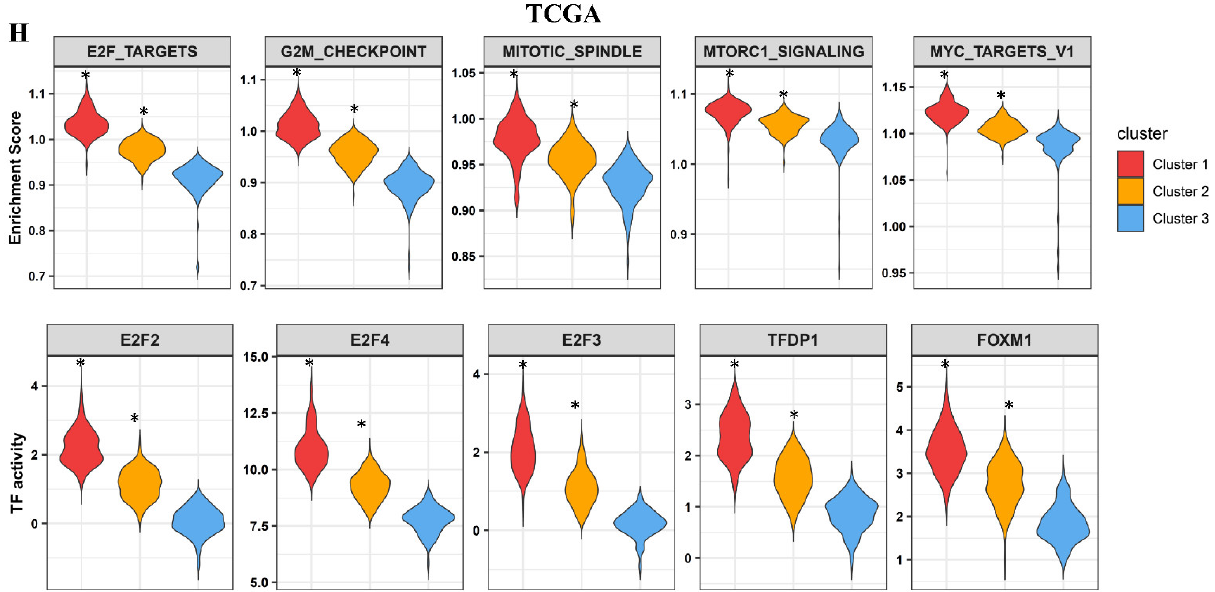
Figure 2. Essential gene-stratified clusters exhibit distinct survival and molecular profiles. ( A ) Similarity matrix of TCGA patients derived from consensus clustering assays shown as a heatmap. ( B ) Cumulative distribution function (CDF) plot used to decide optimal cluster numbers. ( C ) Survival differences within each cluster compared using a log-rank test and demonstrated as a Kaplan-Meier plot. ( D ) Forest plot indicating hazard ratios of essential gene-stratified clusters considering tumor stages. ( E ) Heatmap indicating expressions of essential genes within clusters. The status of the TP53 mutation and chromosome 3q26.2 alterations are demonstrated as annotation plots. The frequency of TP53 mutations ( F ) and chromosome 3q26.2 alterations ( G ) within each cluster are demonstrated. ( H ) Violin plots demonstrating the top signaling and transcription factor (TF) activities that significantly differed within essential gene-classified clusters. * means p < 0.05.